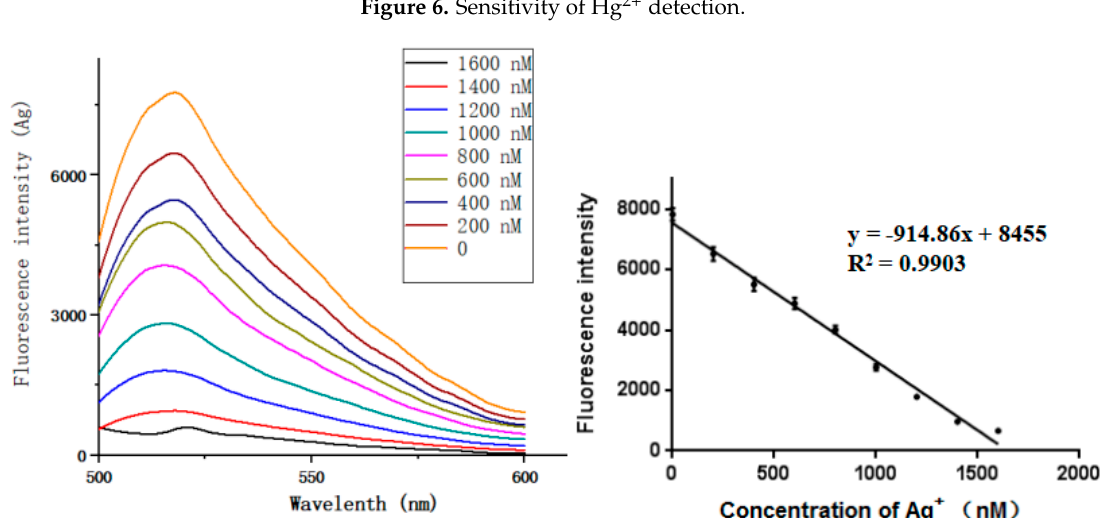
Figure 6. Sensitivity of Hg 2+ detection.